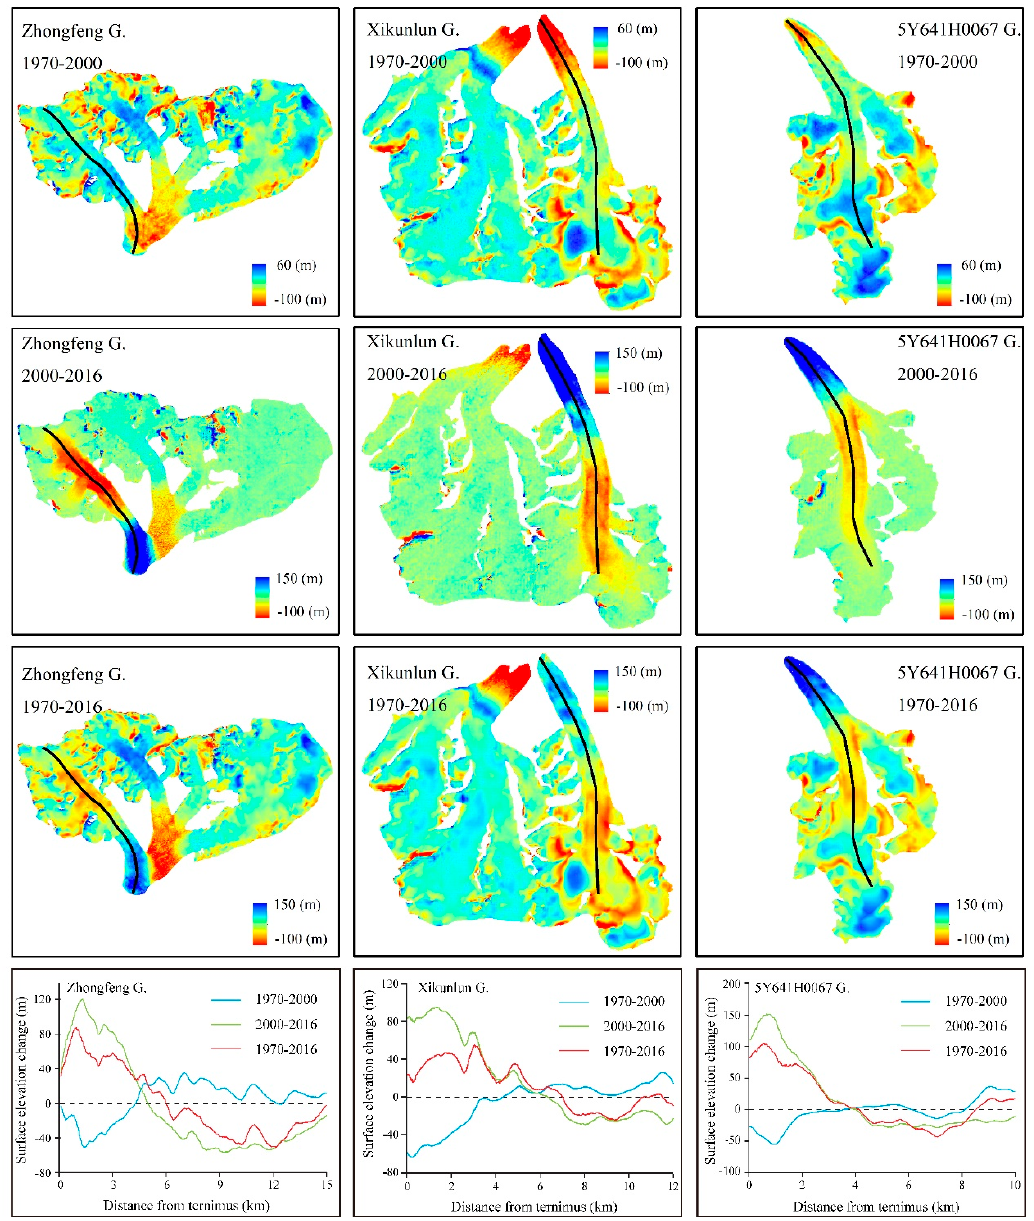
Figure 6. Changes in glacier surface elevation over time periods and their changes along the longitudinal section in the Zhongfeng G., Xikunlun G. and 5Y641H0067 G. The locations of glaciers are shown in Figure 4 in brown font.